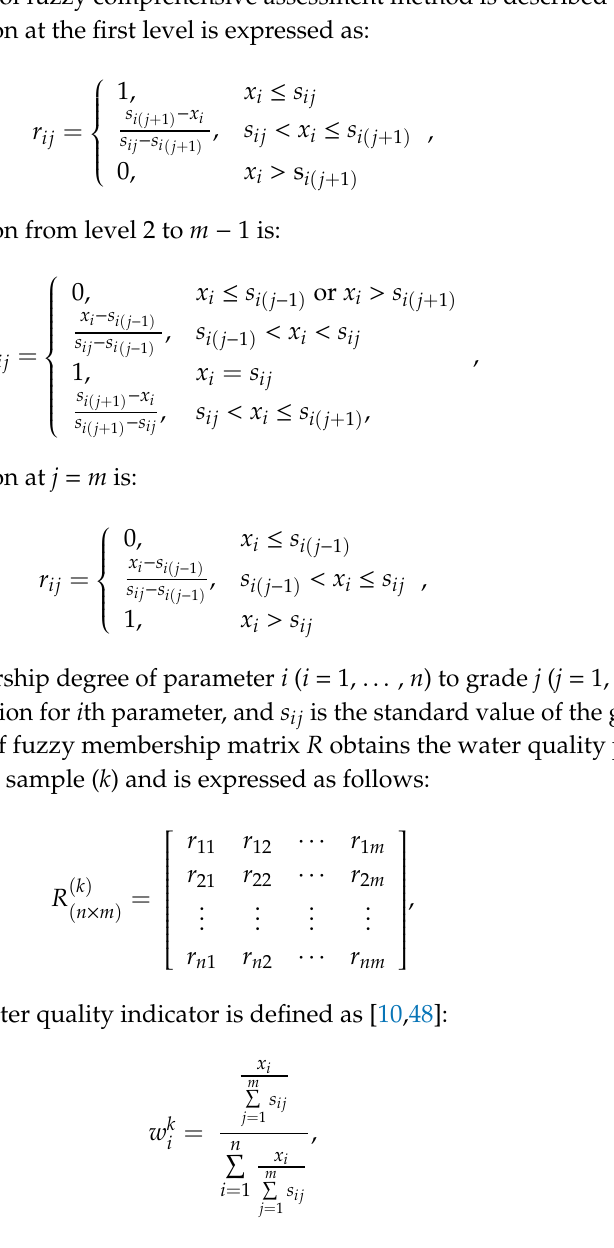
Cl − ≤ 50 ≤ 150 ≤ 350 > 350 F − ≤ 0.2 TDS ≤ 500 > 2000